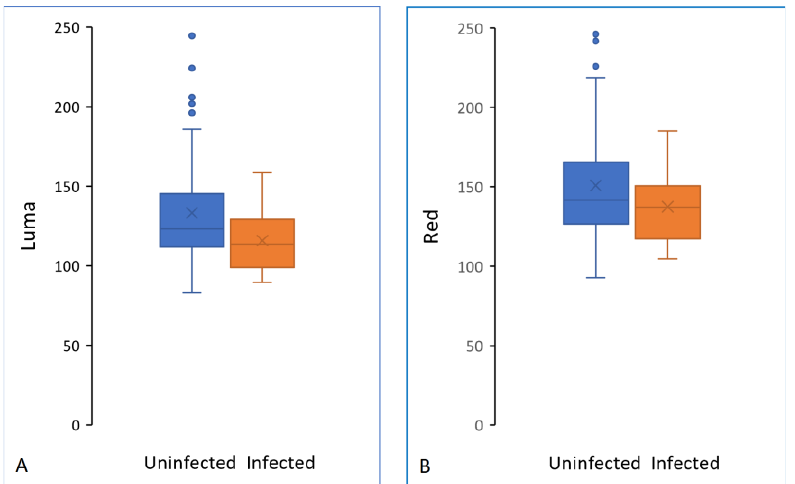
Figure 1. Box-and-whisker plot of ( A ) average luma values and ( B ) average red chroma values for Anolis sagrei infected and uninfected with Plasmodium floridense in Florida, USA. The inner boxes represent the second and third quartiles, whereas the whiskers represent the first (upper) quartile and the fourth (lower) quartile. The lines within the boxes are the medians and the Xs represent the means. Dots display outliers for uninfected lizards. Average luma was significantly different between infected and uninfected lizards whereas average red chroma was not significantly different. Red color values differed slightly but not significantly between infected and uninfected lizards (infected mean = 137.38 ± 22.4; uninfected mean = 150.76 ± 34.6), with redder dewlaps belonging to uninfected lizards. The model for red color with the highest support was infection and SVL, but the infection only model also received support (Table 1).